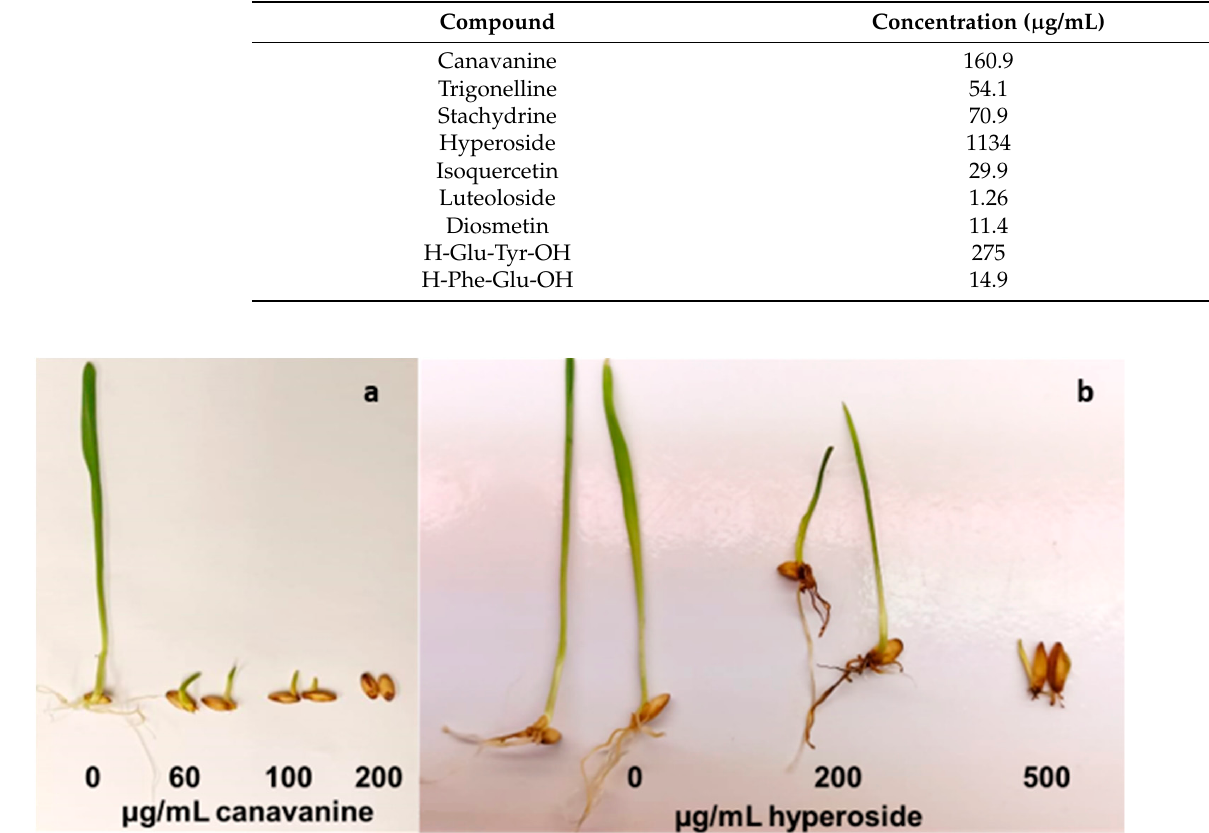
Figure 6. ( a ) Allelopathic e ff ect of canavanine at di ff erent concentrations (60, 100, and 200 µg/mL). ( b ) Allelopathic e ff ect of hyperoside at di ff erent concentrations (200 and 500 µg/mL) after 10 days.